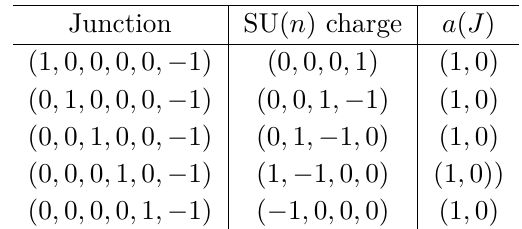
Table 2 . The 5 junctions corresponding to 5 of SU(5) near the point of enhancement z = P = 0 . The middle column is the charge of the state under the Cartan U(1) ’s of SU(5) . a ( J ) is computed with respect to S . The 5 junctions corresponding to 5 are the orientation reversed junctions of G the ones listed